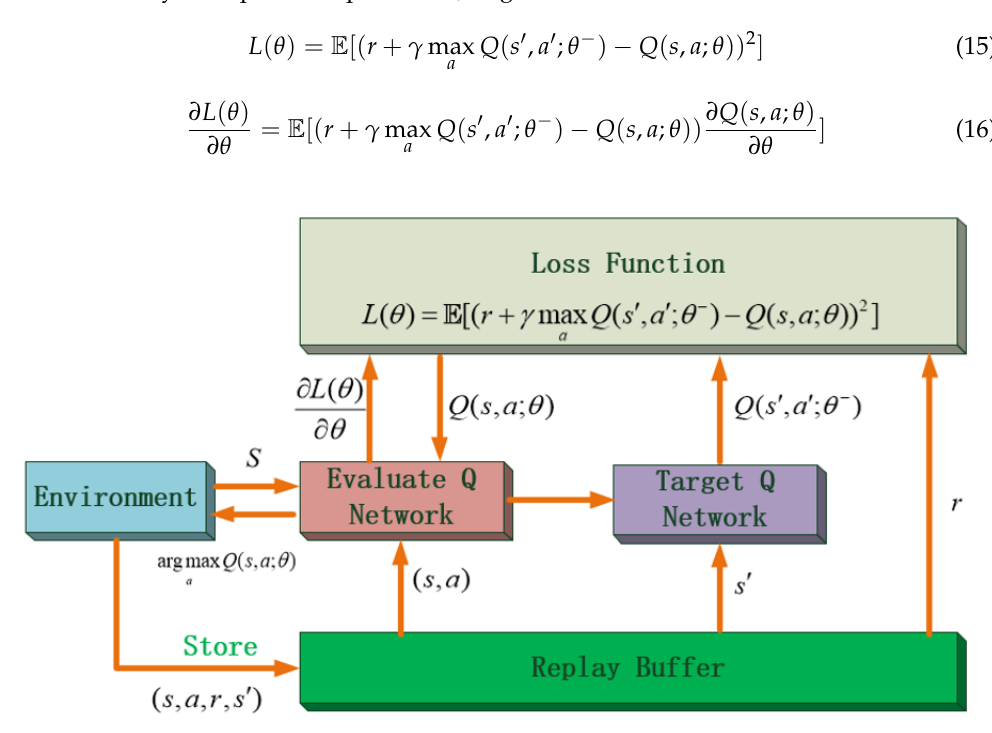
Figure 8. The update process of the deep Q learning